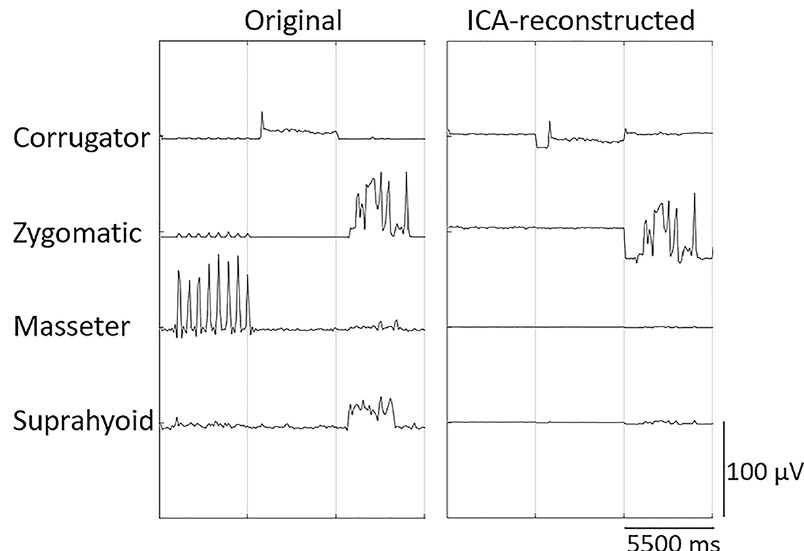
Figure 2. Examples of original and independent component analysis (ICA)-reconstructed electromyography signals from the corrugator supercilii, zygomatic major, masseter, and suprahyoid muscles. Data for three trials (a total of 16.5 s; each trial contained 0.5-s pre- and 5-s post-stimulus periods) of a representative participant are shown. To remove crosstalk arising from the masseter and suprahyoid muscle activities, the signals were reconstructed using the independent components that exhibited the highest variance with respect to the corrugator supercilii and zygomatic major muscle activities.